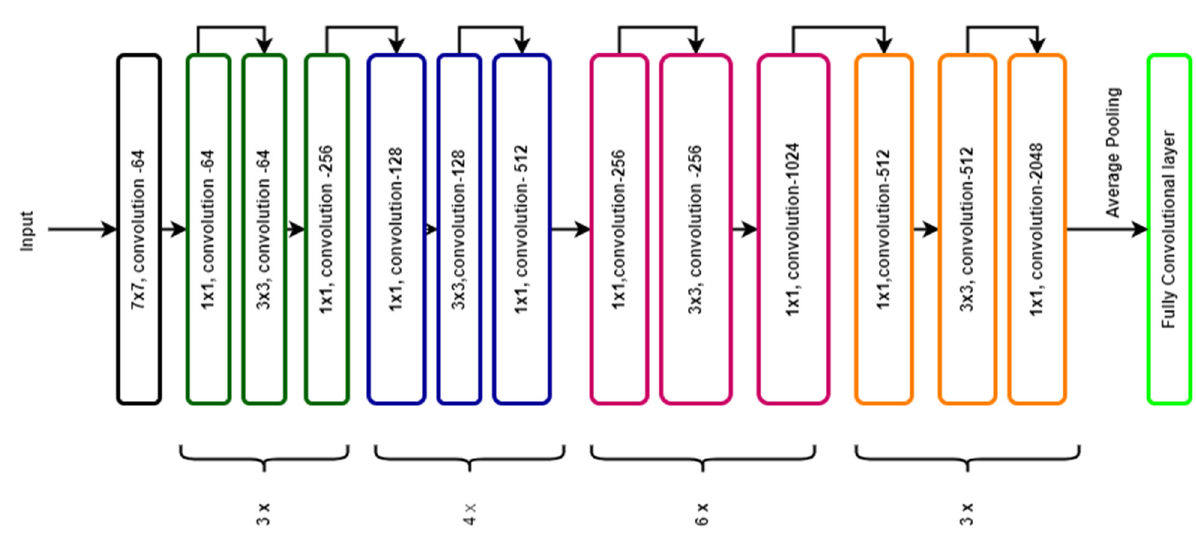
Figure 4. Block diagram of the ResNet-50 architecture.